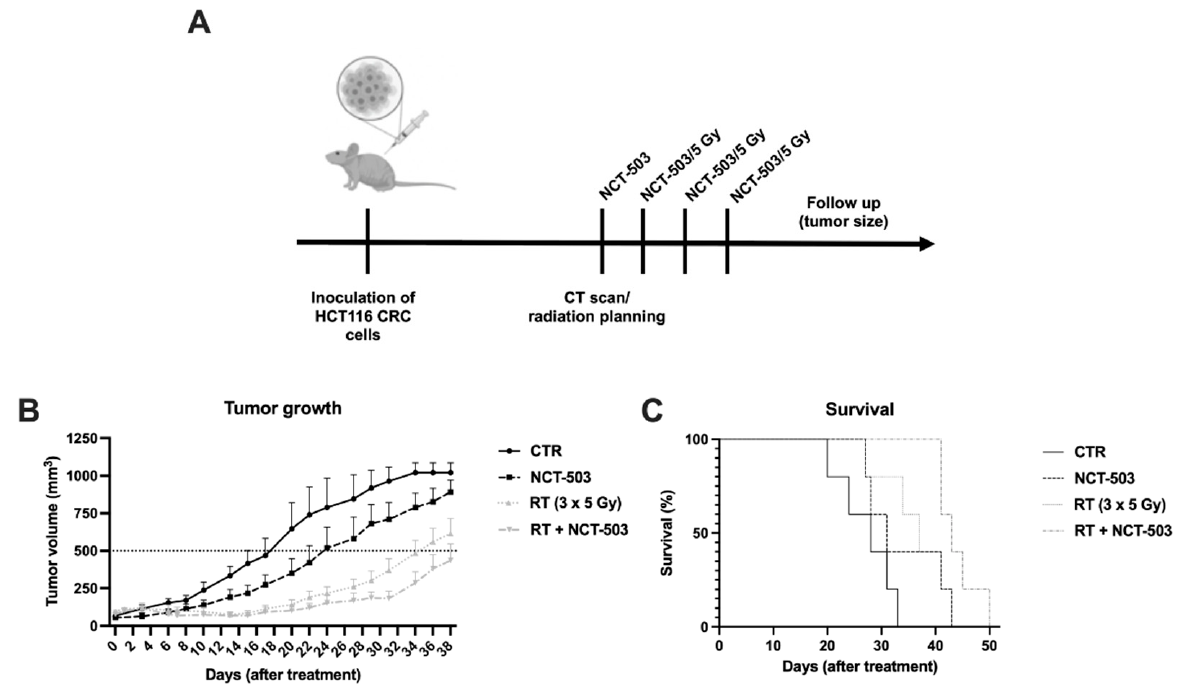
Figure 7. Inhibition of PHGDH combined with fractionated radiation delays tumor growth in HCT116 xenografts. ( A ) Representative schedule of the experimental setup in vivo. ( B ) Tumor growth curve of mice with day 0 as the starting point of treatment. ( C ) Survival curve of mice with day 0 as the starting point of treatment. Data are shown as mean with SEM ( n = 5).